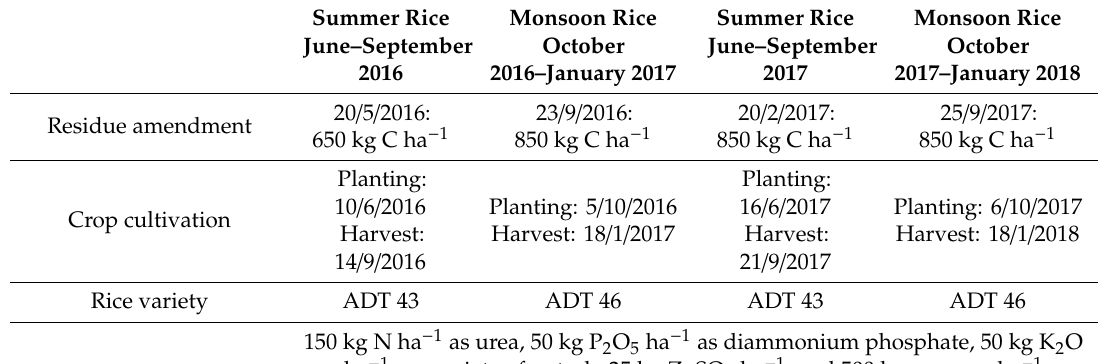
Table 1. Field management practices. Dates are described as Day / Month /